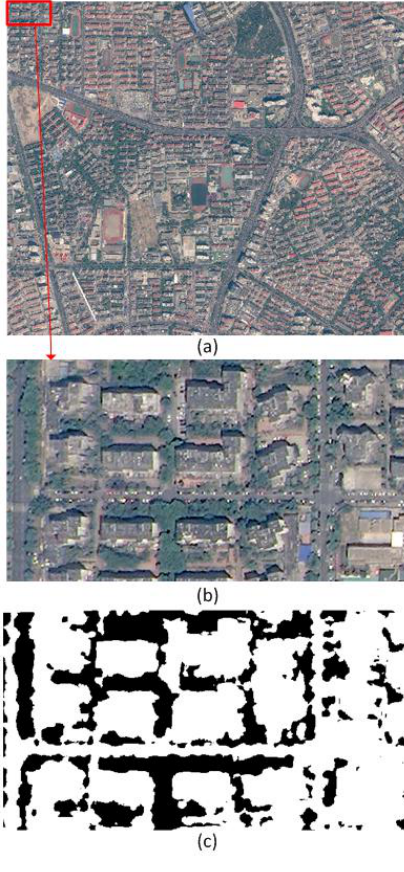
Figure 2. Illustration of the training sample